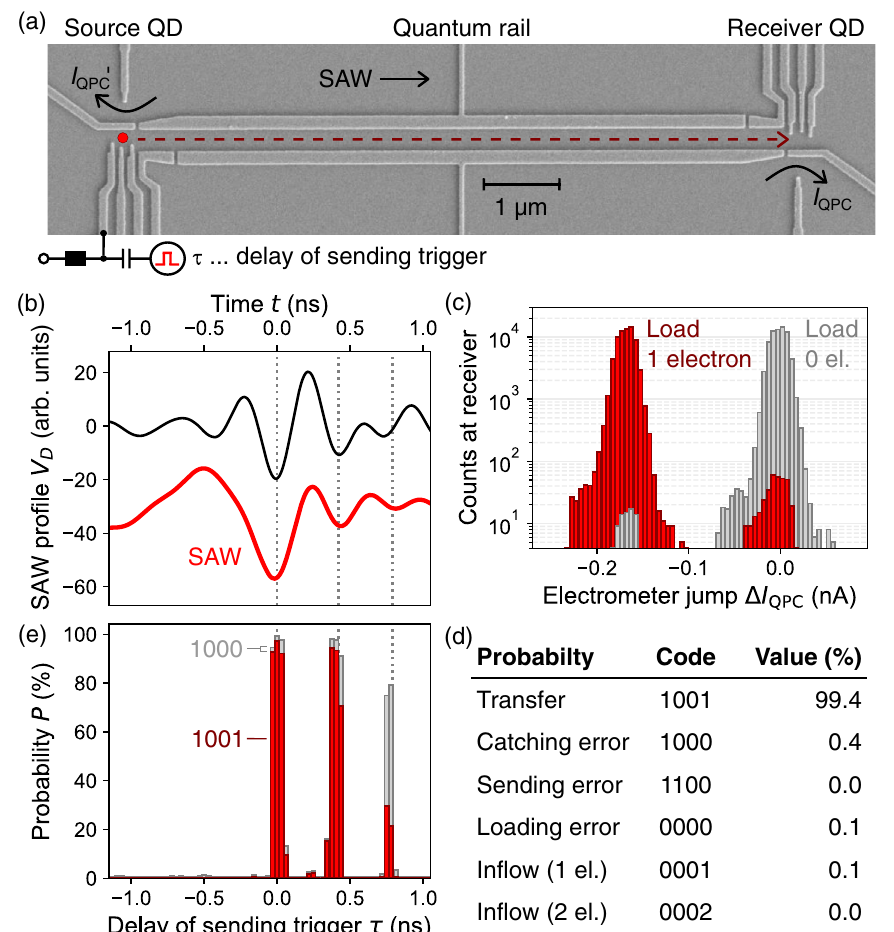
FIG. 5. Electron shuttling along quantum rail. (a) SEM image of the quantum rail consisting of two surface-gate-defined quantum dots (QD) that are connected via a depleted transport channel. We further show the quantum-point-contact (QPC) electrometers that are placed next to each QD to sense the presence of electrons. (b) Time-dependent measurement of the chirped pulse in the cryogenic setup via the SAW detector (black). The offset red line shows the corresponding SAW profile extracted via deconvolution of the detector ’ s response function. (c) Histogram of jumps in the electrometer current Δ I at the receiver QD from 70 000 single-shot measurements after QPC launching the SAW pulse with (red) and without (gray) precedent loading of an electron in the source QD. (d) Table of transfer and error probabilities with QD-occupation code of the events (source before, source after, receiver before, receiver after). (e) Successful (1001) and failed (1000) transfer probabilities as a function of the trigger delay τ of the sending process with respect to the SAW